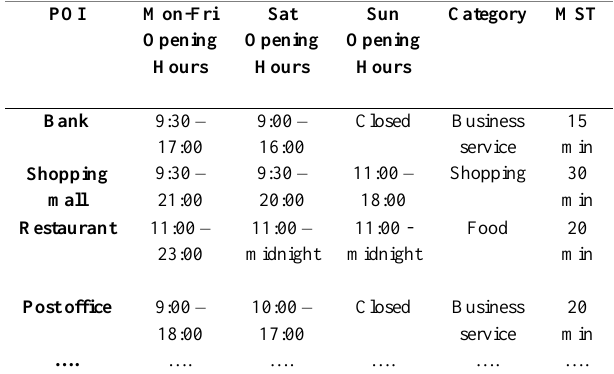
Figure 9. Land use type distribution for user trajectory.